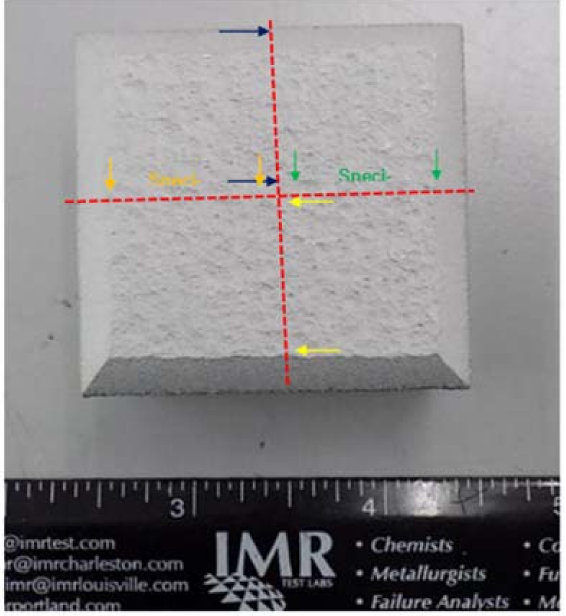
Figure 2. Specimen extraction for the microstructure analysis for the Al-2024